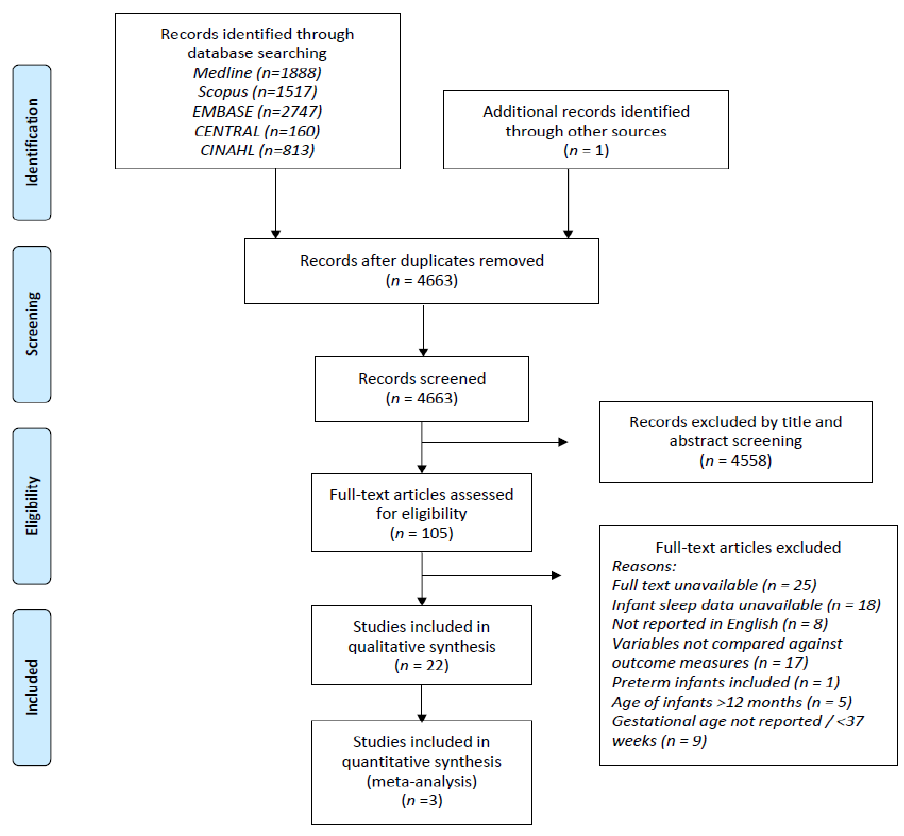
Figure 1. Preferred Reporting Items for Systematic Reviews and Meta-Analyses (PRIMSA) flow chart. The PRISMA flow chart is used for identification and selection of articles to be included for systematic review. A total of 7125 abstracts were retrieved using the search strategy. After removal of duplications, 4663 were screened by title and abstract, leaving 105 studies eligible for full-text review. Among the eligible studies, 84 articles were excluded due to the reasons listed. The remaining 21 studies were included for qualitative